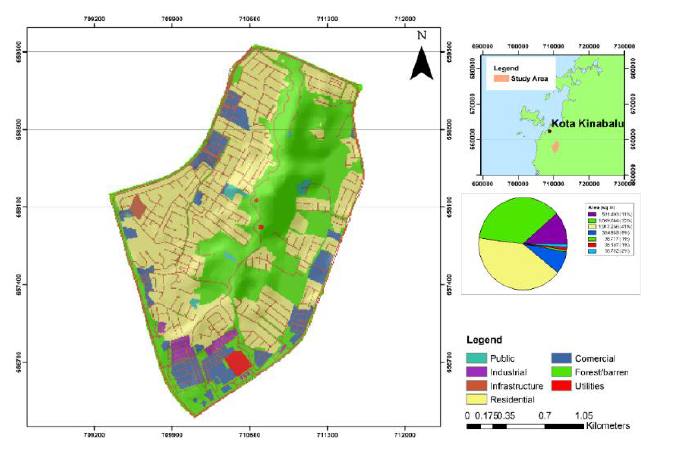
Figure 4: The landuses within and adjacent to the study area